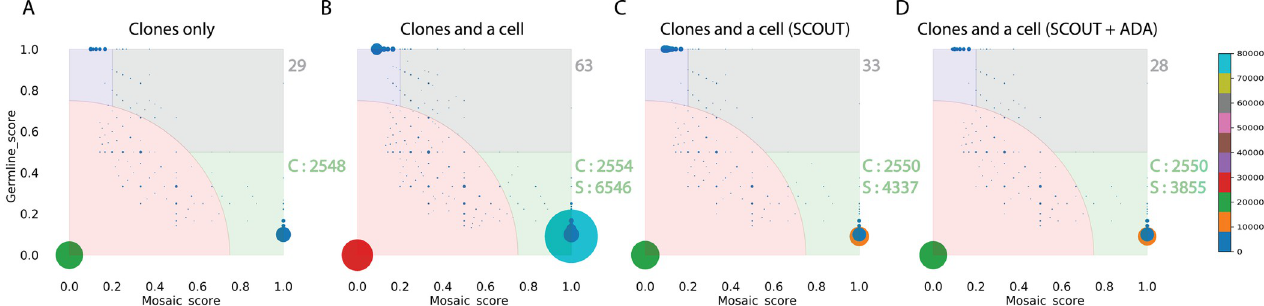
Fig 3. All 2 in ADA mode reduces false positive calls from allele dropout in MDA. (A) Score distribution when applying All 2 to 11 clones derived from single brain progenitor cells. There are 29 calls for high frequency (gray area) and 2548 calls for low frequency (green area) mosaic mutations. The ‘C’ points to mosaic calls in the clones). (B) Adding one MDA amplified cell to the analysis results in double the number of calls for high frequency mosaic mutations. Noise also increases. The ‘S’ points to the calls coming from the single cell. (C) Application of a specialized single cell caller SCOUT on the single cell partially mitigates issues with calling, i.e., reduces the noise and the number of mosaic calls. (D) Applying the ADA mode results in almost the same set of high frequency mosaic mutations. The mode also reduced calls for mosaic mutations in single cell without affecting calls in the clones. The color (and size) of the circles corresponds to the number of mutations sharing the same scores as depicted in the colorbar. The mosaic mutations are represented by the light green area, germline muations are represented in light blue area, high frequency mosaic mutations are represented in the light gray area and noise is represented by the light red